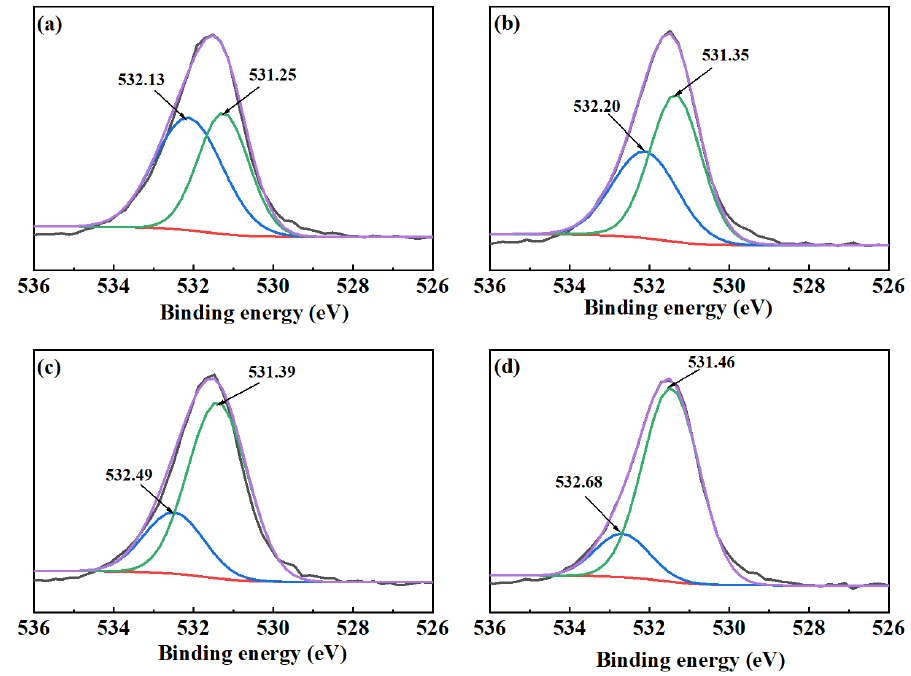
Figure 7. O1s XPS spectra of cerussite treated with different conditions: ( a ) cerussite, ( b ) cerussite + Pb 2+ , ( c ) cerussite + Na 2 S, and ( d ) cerussite + Pb 2+ + Na 2 S.